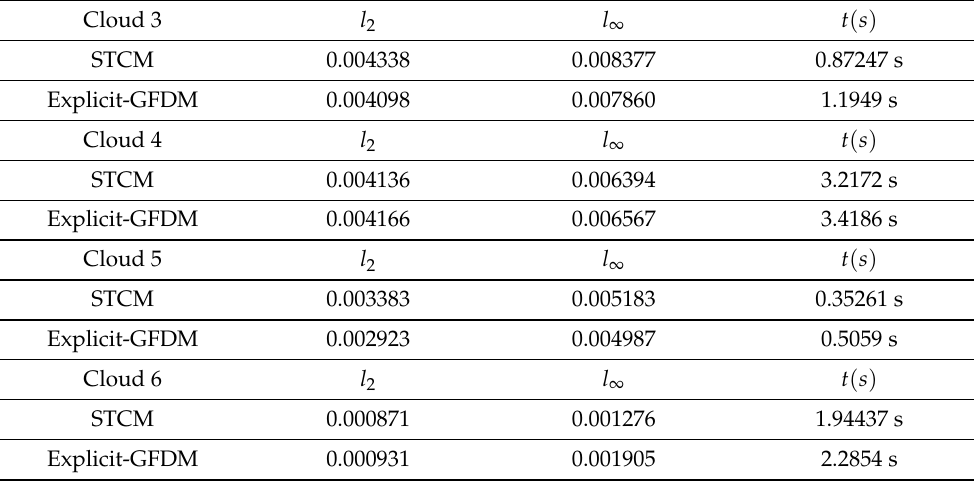
Table 4. Errors and execution time of Example 4 in the clouds of Figures